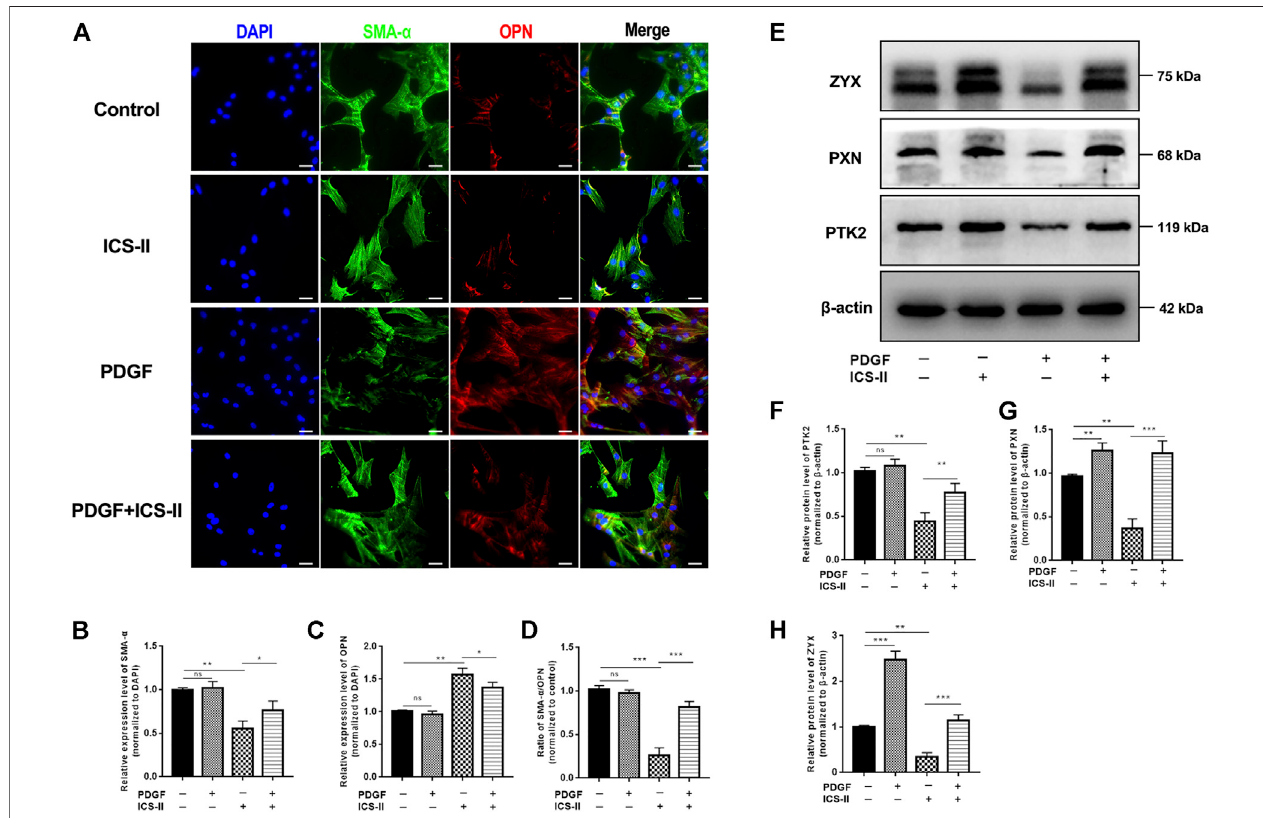
FIGURE5| ICS-IIrestoredVSMCcontractilephenotypethroughthefocaladhesionsignalingpathway. (A) Co-stainingofSMA- α (green)andOPN(red)forcontrol, ICS-II, and PDGF-BB and PDGF-BB + ICS-II groups, respectively. Quanti fi cation of the relative expression level of (B) SMA- α , (C) OPN, and (D) ratio of SMA- α /OPN, respectively. (E) WesternblotimagesforPTK2,PXN,andZYX.Quanti fi cationof (F) PTK2, (G) PXN,and (H) ZYXproteinlevels,respectively.Scalebar=20 μ m;Dataare presented as mean ± S.E.M. N = 5 per group. * p < 0.05, ** p < 0.01, *** p < 0.001, **** p <